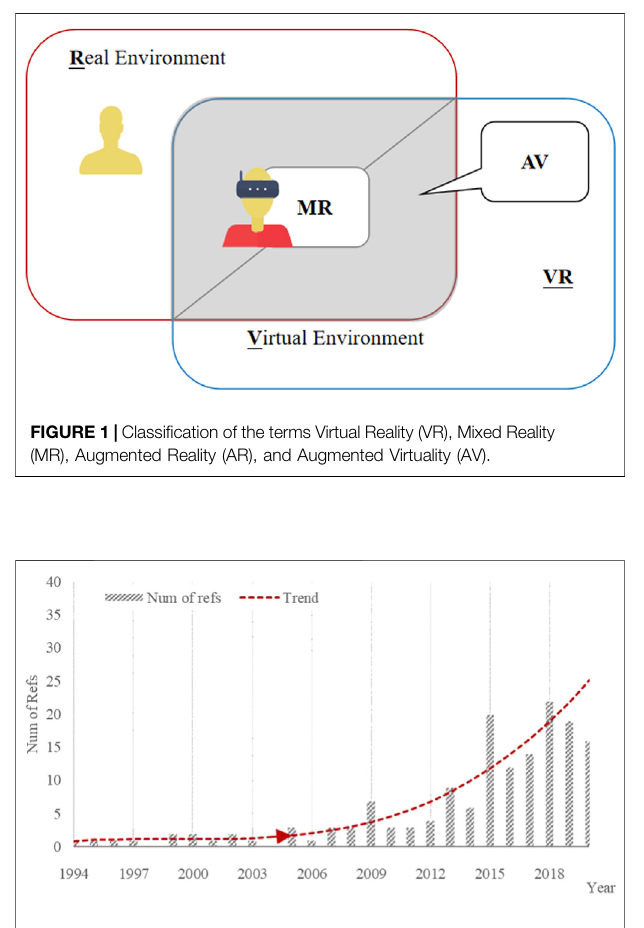
FIGURE 2 | AR implementation development in civil infrastructure.